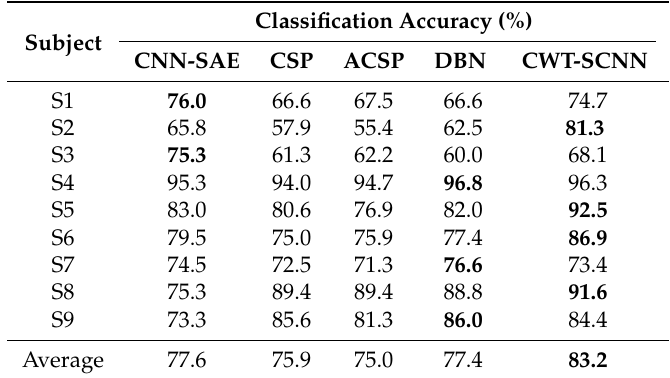
Table 2. The classification results for five methods. Convolutional neural network and stacked (ACSP) [45], deep belief net